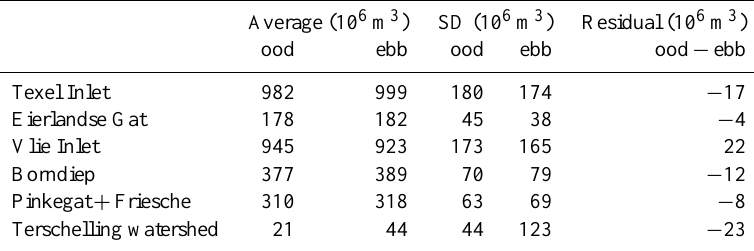
Table 2. Average, standard deviation (SD), and residual of the flood and ebb tidal prisms for all inlets and the Terschelling watershed. For convenience, flood at the watershed is defined as having a flow from east to west.